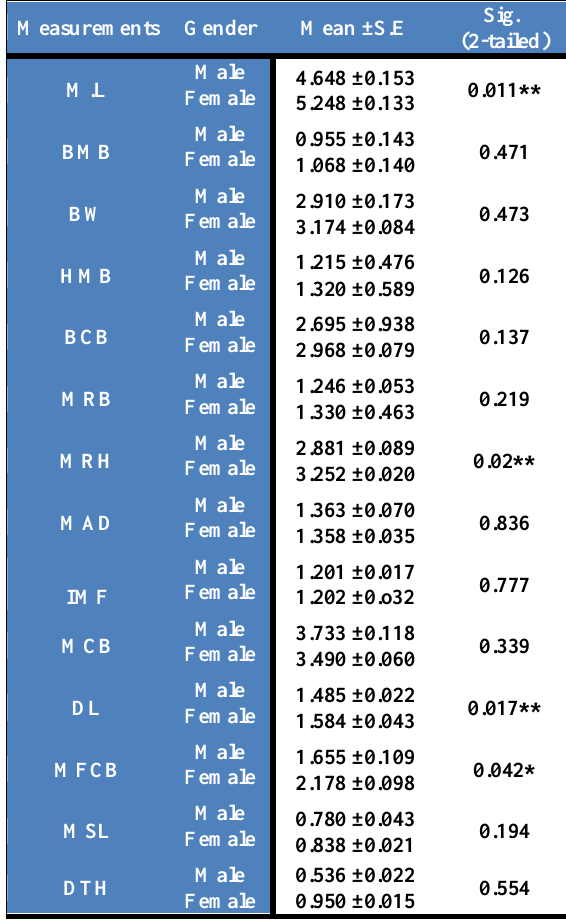
Table, 1: The measurements of the mandible of the local rabbits.